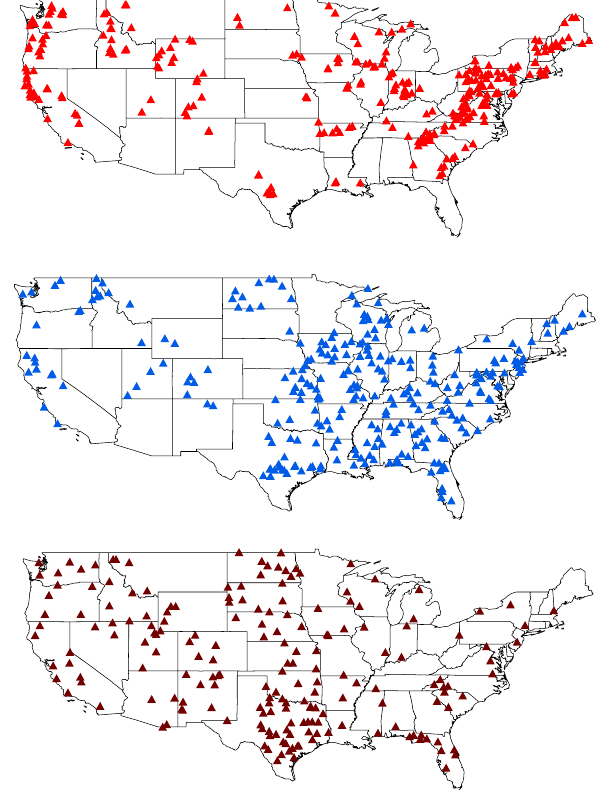
Fig. 3. (a) Group 1 catchments with NS > 0.7 (red triangle), (b) Group 2 catchments with 0.3 < NS < 0.7 (blue triangle), and (c) Group 3 catchments with NS < 0.3 (brown triangle).